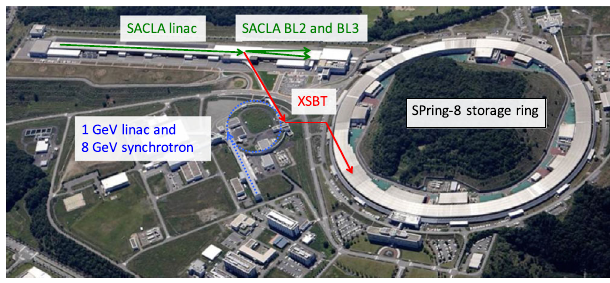
FIG. 1. Bird ’ s-eye view of the SPring-8